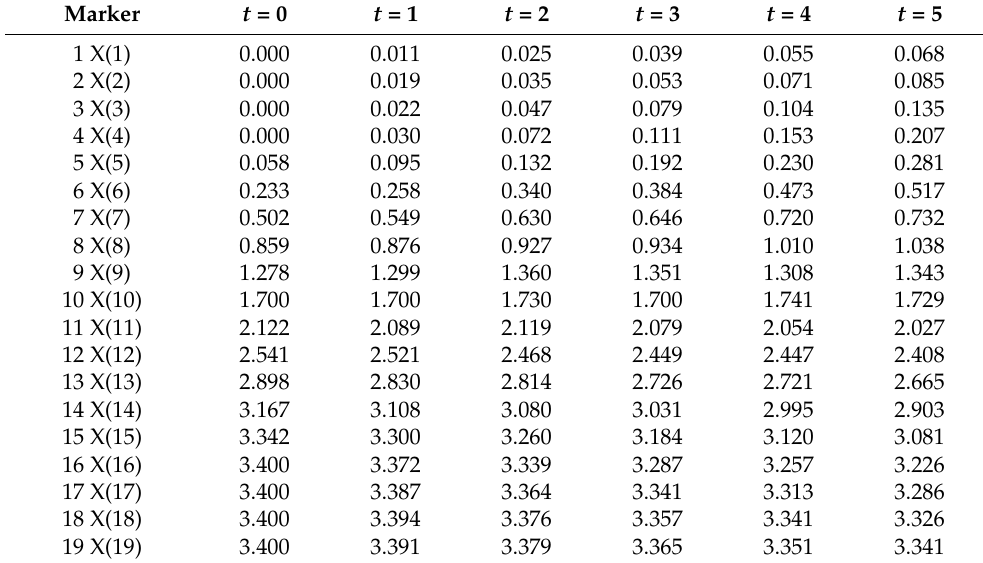
Figure 5. Gate road cross section with marker positions. Table 1. X coordinates of the markers ( m ).